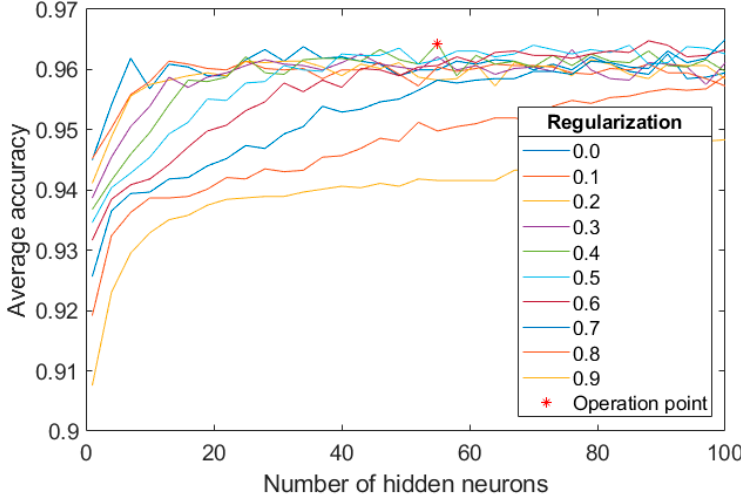
Figure 6. Average accuracy for RL classification over the validation set obtained during MLP training for varying the number of hidden neurons and the regularization parameter.